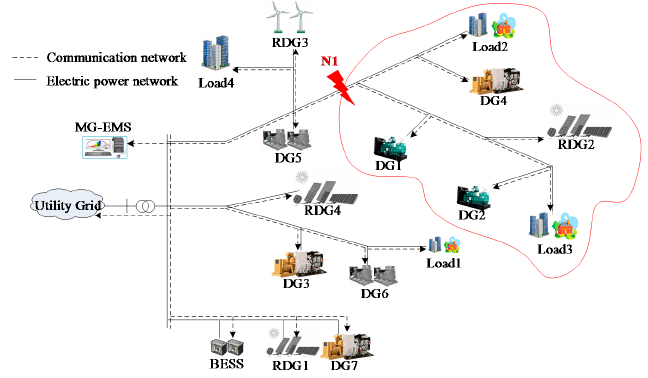
Figure 10. Case 1: Simulated scenario for evaluating proposed strategy during emergency mode operation.